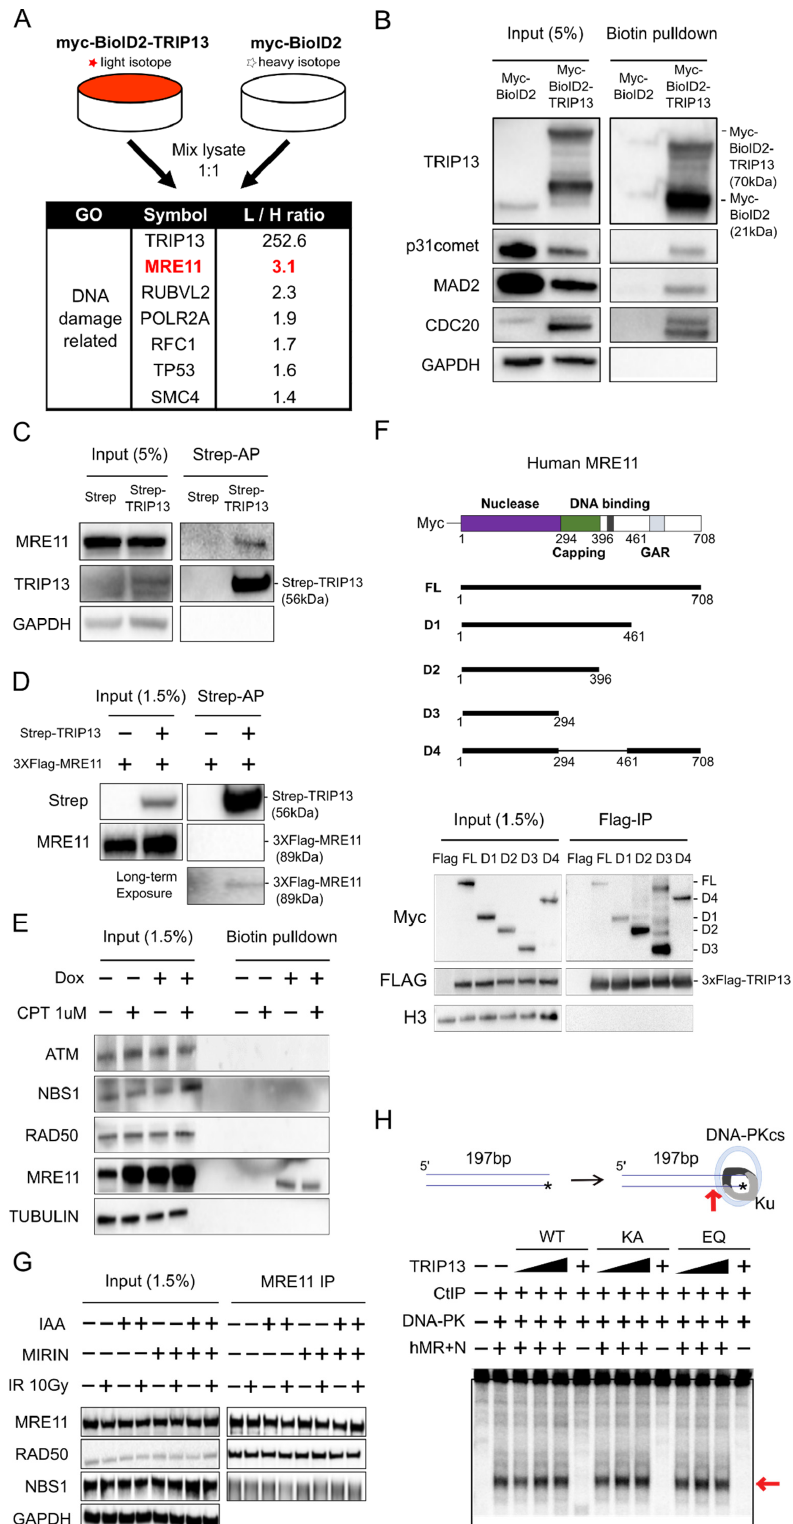
Figure 2. MRE11 is a novel interaction partner of TRIP13. ( A ) A proteomics experiment with BioID2-tagged TRIP13 identified 279 candidate interaction partners. ( B ) Well-known substrates of TRIP13 (p31comet, MAD2, and CDC20) were labeled by BioID2-TRIP13. ( C ) Endogenous MRE11 was detected by Strep-AP using Strep-tagged TRIP13. ( D ) Purified 3xFLAG tagged MRE11 was